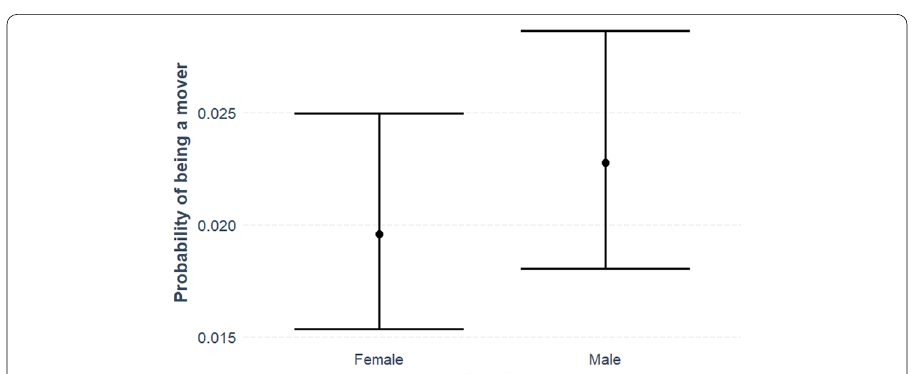
Fig. 3 Model 2: estimated marginal probabilities with respect to